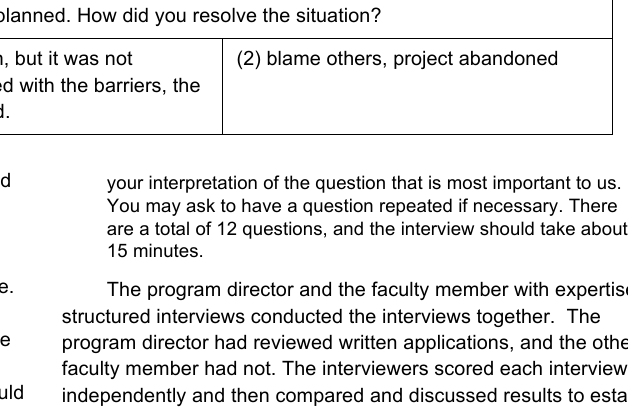
Table 3. Sample Interview Question for the Attribute of